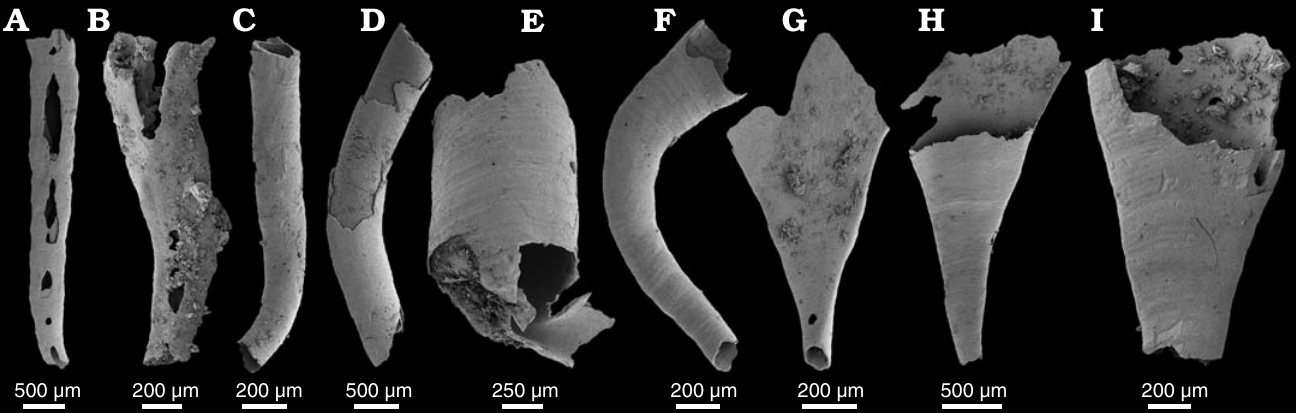
Fig. 19. The hyolithelminth tubes from the lower Cambrian White Point Conglomerate, Kangaroo Island, South Australia. Sphenothallus -like tubes ( A , SAM P57368; B , SAM P57369). Tubes with circular cross-section ( C , SAM P57370; D , SAM P57371; E , SAM P57372; F , SAM P57373). Expanding tubes ( G , SAM P57374; H , SAM P57375; I , SAM